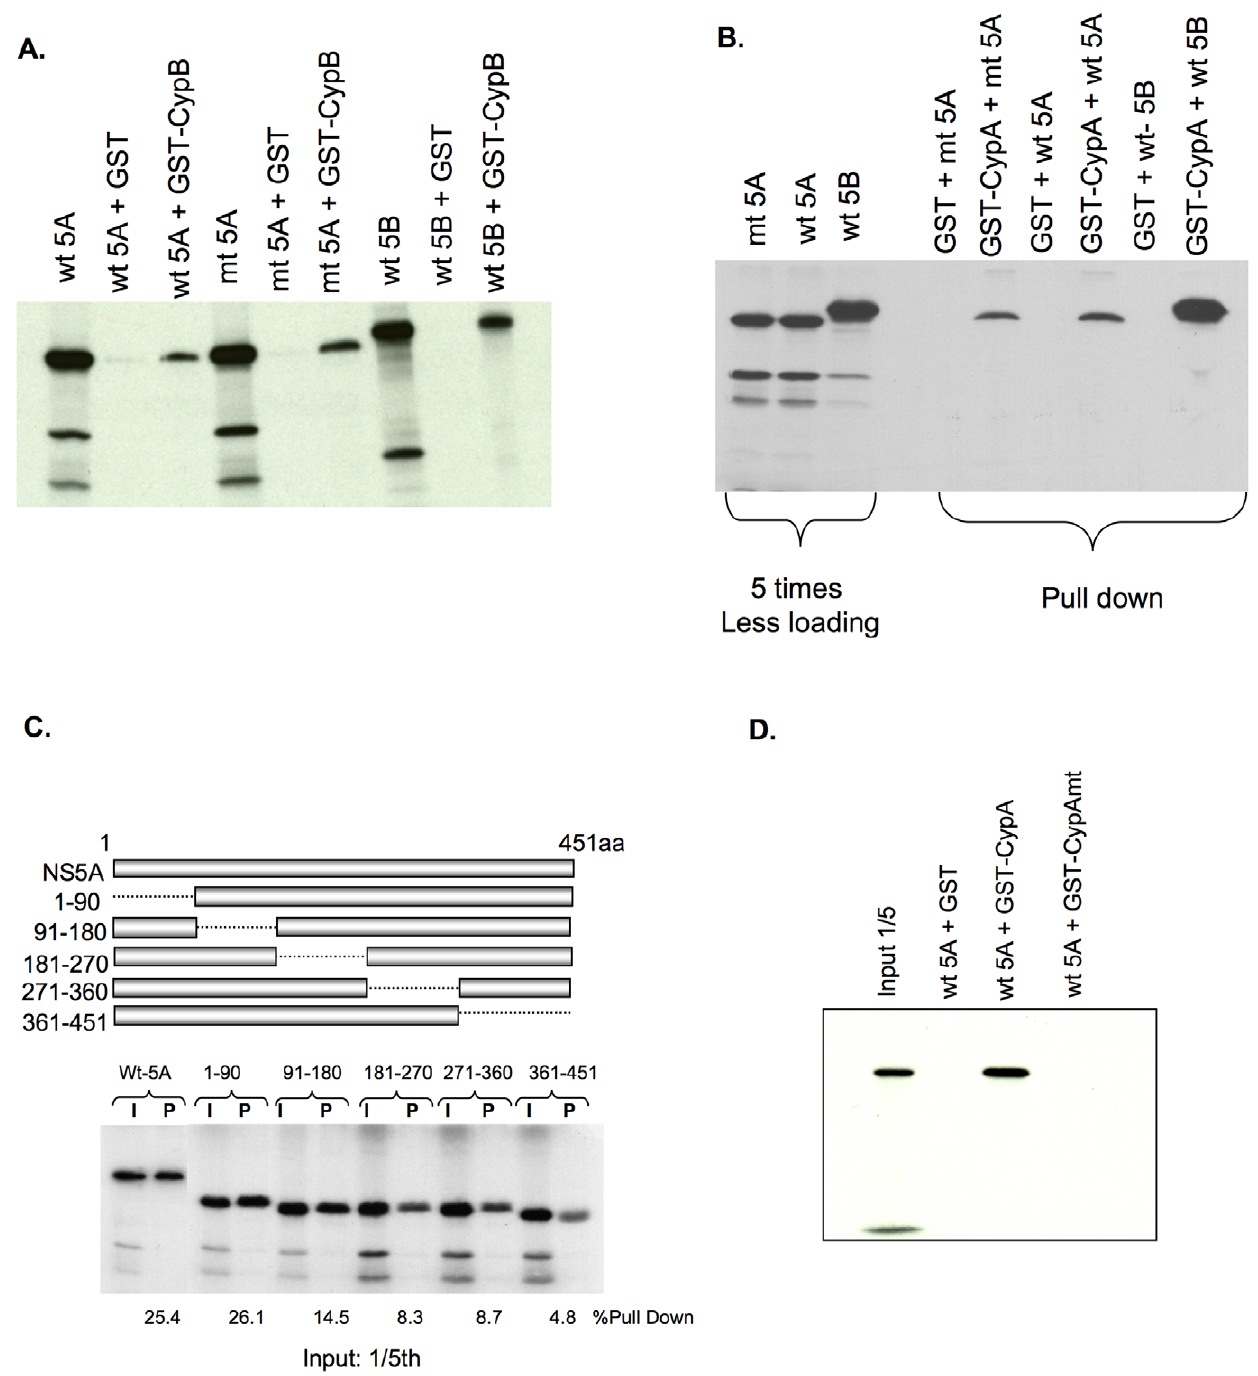
Figure 5. NS5A binds both CypB and CypA. (A) wt-NS5A, mt-NS5A, and wt NS5B-FLAG (1bN) were labeled with 35 S methionine/cysteine by in vitro translation. Labeled proteins were incubated with either GST alone (Lanes 2, 5, and 8) or GST-CypB (Lanes 3, 6, and 9). Gluthathione Sepharose beads were used to purify GST-containing complexes from the binding mixture. After separation via SDS-PAGE, 35 S-labeled proteins were detected by autoradiography. Lanes 1, 4, and 7 contain labeled proteins used in the binding assay. (B) The wt-NS5A, mt-NS5A, and wt NS5B-FLAG (Con 1b) were in vitro translated and incubated with either GST alone or GST-CypA. The GST binding assay was performed as described in (A). The left three lanes contain labeled proteins used in the binding assay. (C) The binding region within the NS5A region for CypA was mapped by generating 90 amino acids in-frame deletion mutants. The radiolabeled mutant proteins were incubated with GST-CypA as above. Input protein (I) was loaded at 1/5 volume alongside the corresponding pull-down product (P). Pulled down signal was quantified using Storm and % values of pull down are shown for each deletion mutant. (D) The CypA containing mutations in the isomerase active site was analyzed for binding to wt-NS5A using GST binding assay.